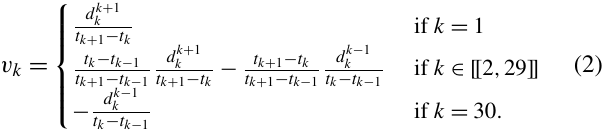
Figure 14. Pore size distribution, with two voxels = 13mm bin size computed using a fitting sphere algorithm. Vertical dotted lines represent the mean of the associated